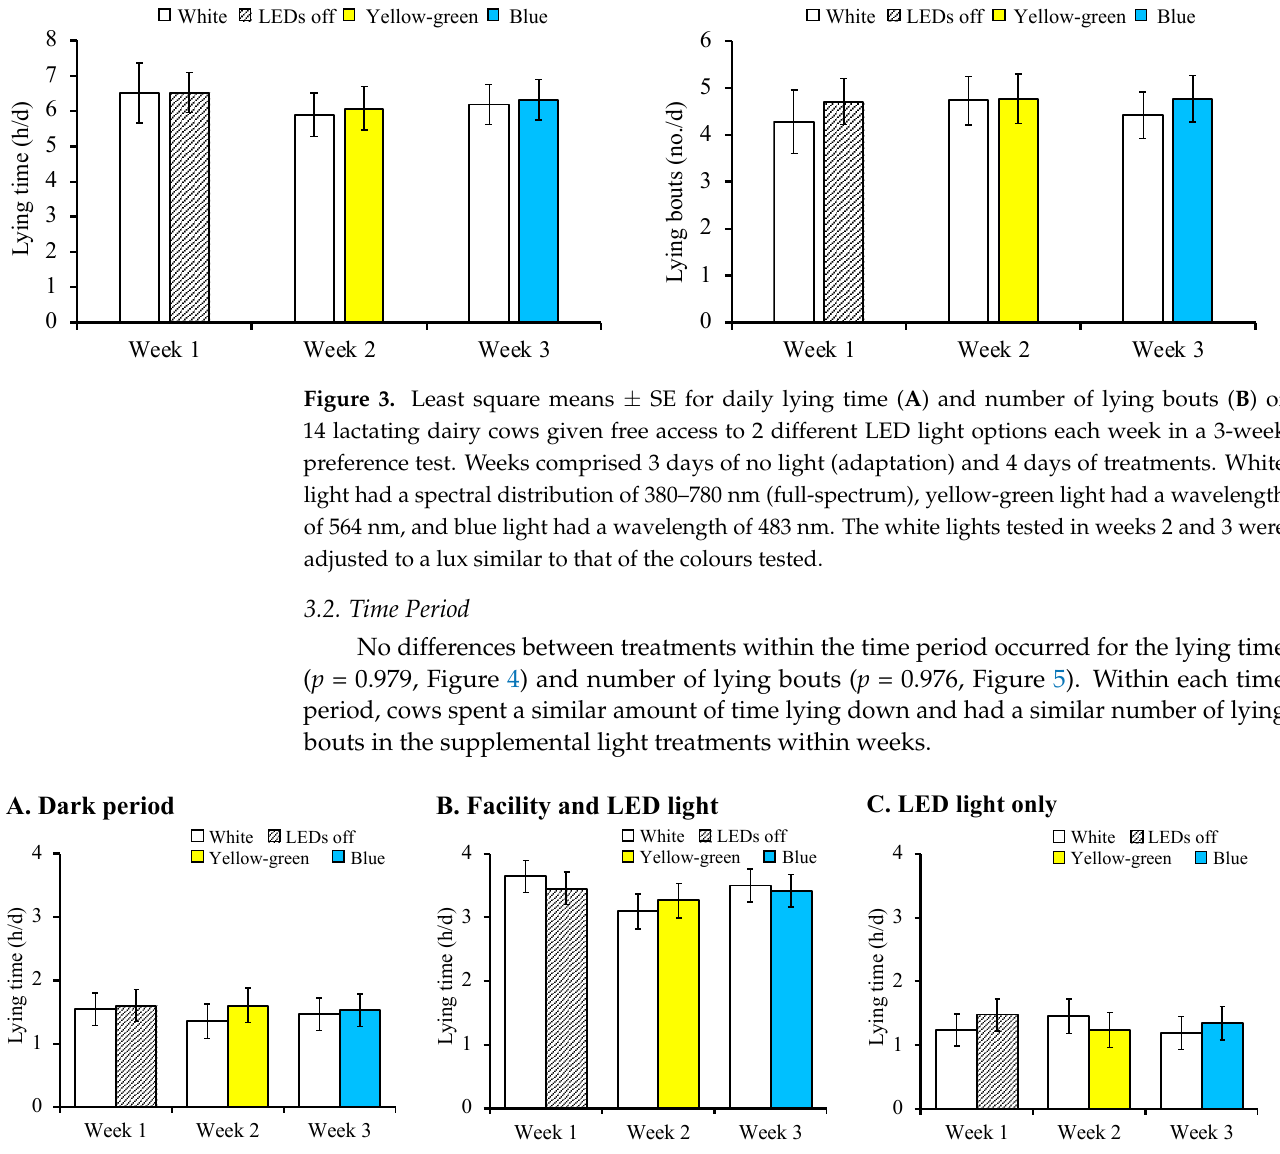
Figure 4. Least square means ± SE for lying time during the dark period ( A ), facility and LED lighting period ( B ), and LED light only period ( C ). Fourteen lactating dairy cows given free access to two different LED light options each week in a three-week preference test. White light had a spectral distribution of 380–780 nm (full-spectrum), yellow-green light had a wavelength of 564 nm, and blue light had a wavelength of 483 nm. The white lights tested in weeks 2 and 3 were adjusted to a lux similar to that of the colours tested. Weeks were comprised of 3 days of no light (adaptation) and 4 days of treatments. To account for the facility lighting, lying time was analysed in each time period. The dark period was from 0000 to 0400 h, the facility and LED light period was from 0400 to 2000 h, and the LED light only period was from 2000 to 0000 h.